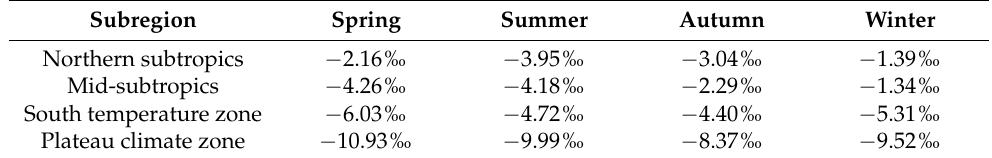
Figure 3. Monthly variation of ∆ d in the Yangtze River Basin. Each climate zone is marked with different colors: northern subtropics (gray), mid-subtropics (red), south temperate zone (blue), and plateau climate zone (green). Table 1. The average value of Δ d in different regions of the Yangtze River basin in different seasons.